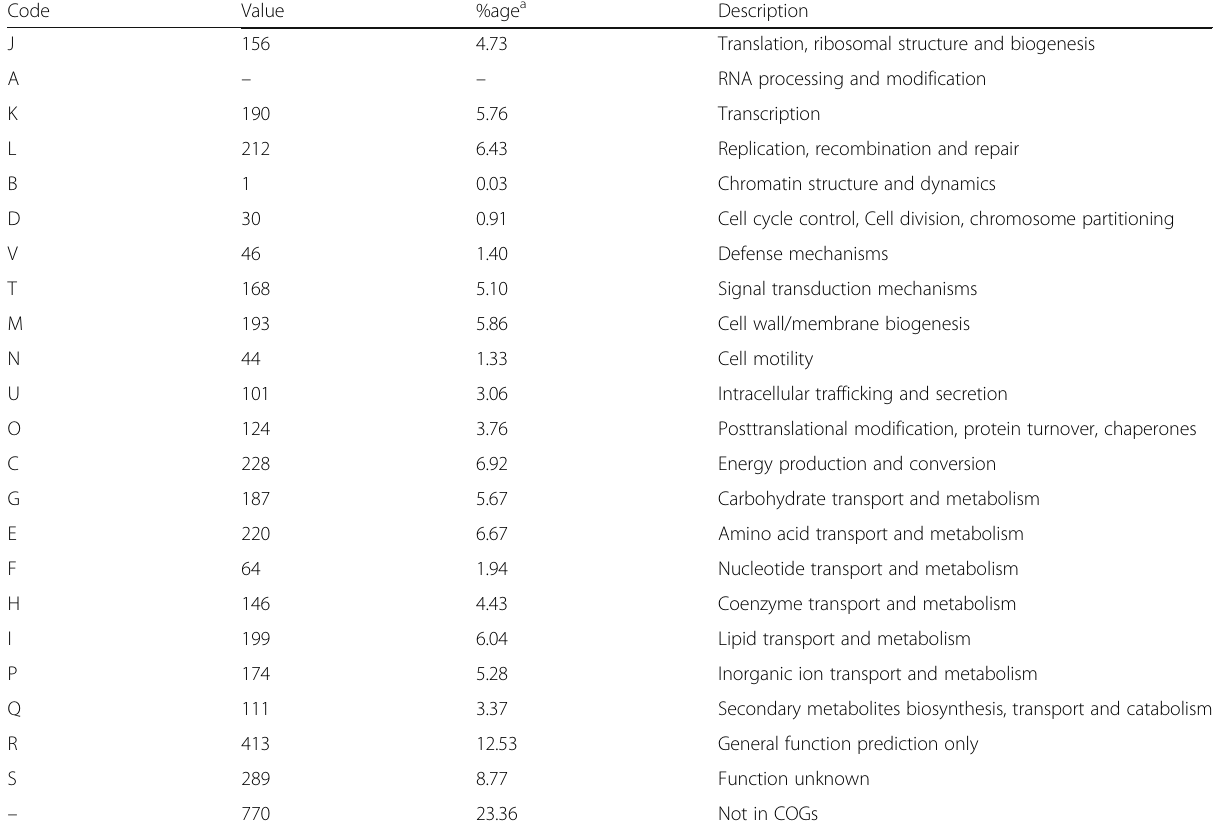
Table 5 Number of genes associated with general COG functional categories